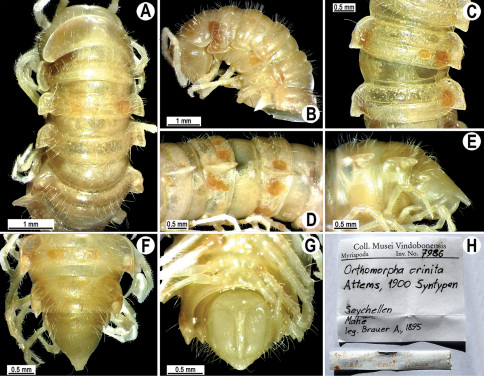
Orthomorpha crinita Attems, 1900, ♀ syntype. A, B anterior part of body, dorsal and lateral views, respectively C, D segments 10 and 11, dorsal and lateral views, respectively E–G posterior part of body, lateral, dorsal and ventral views, respectively H samplelabels.